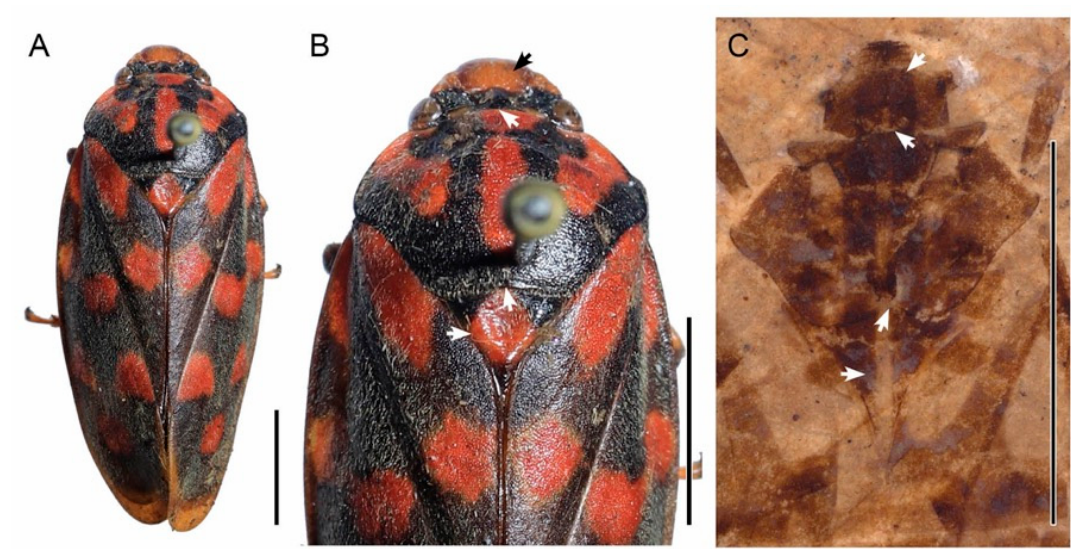
Figure 3. Nangamostethos tibetense sp. nov. and some modern Cercopidae. ( A , B ) Phymatostetha dorsivitta , collection of Kunming Institute of Zoology (Collected from Xinping, Yuxi City, Yunnan Province, China on 12 August, 1978. Collector not recorded). ( C ) Head and thorax of XDB3-1209. The arrows in ( B , C ) indicate the differences between the fossil and Phymatostetha. Scale bars: 5 mm.